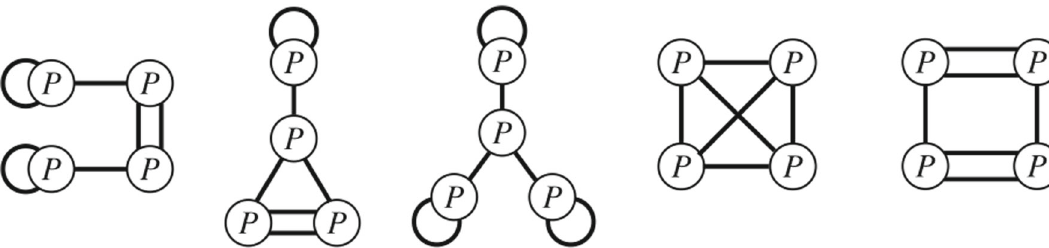
Fig. 8 The Feynman diagrams for the forth order interaction term, (cid:8) ( P φ 3 ) 4 (cid:9) c φ